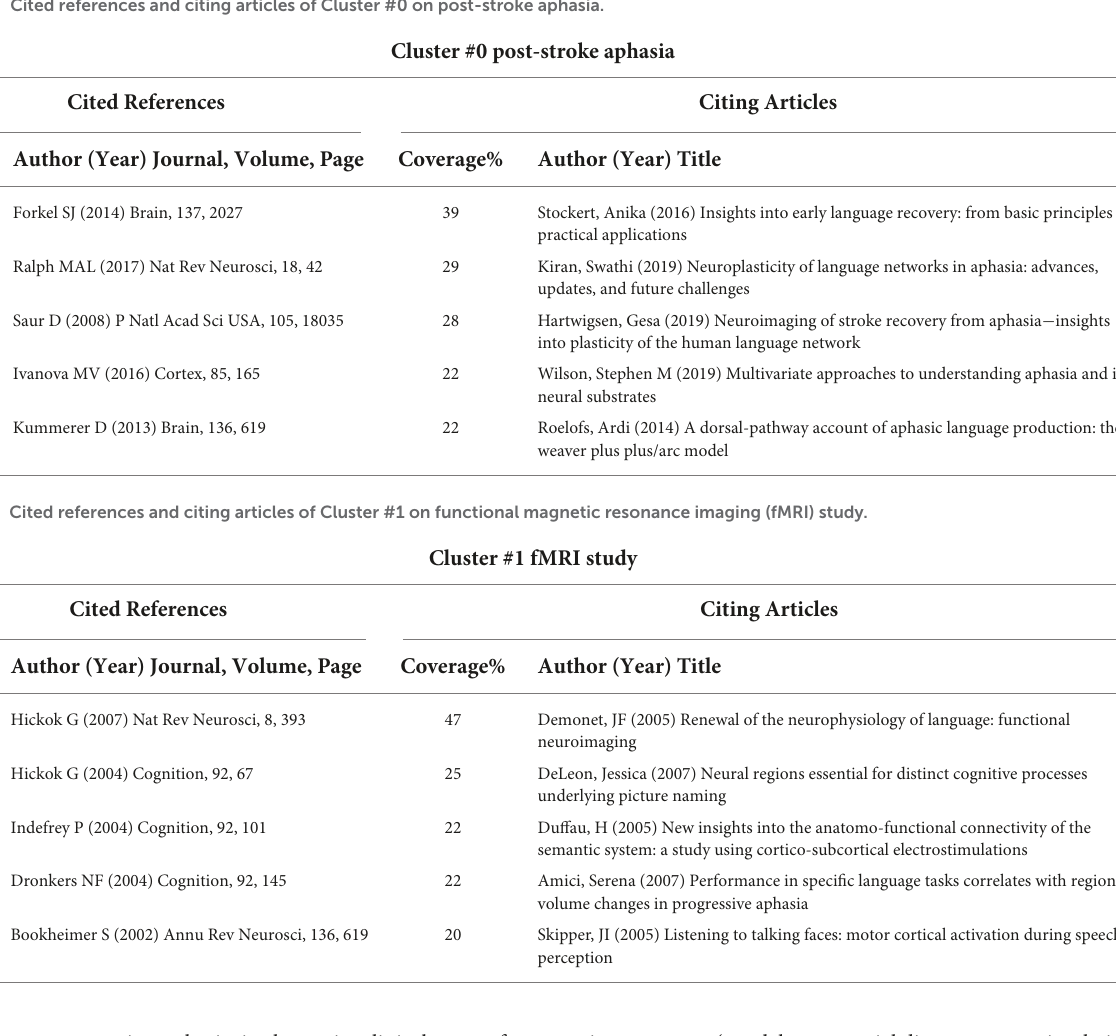
TABLE 4 Cited references and citing articles of Cluster #0 on post-stroke aphasia.